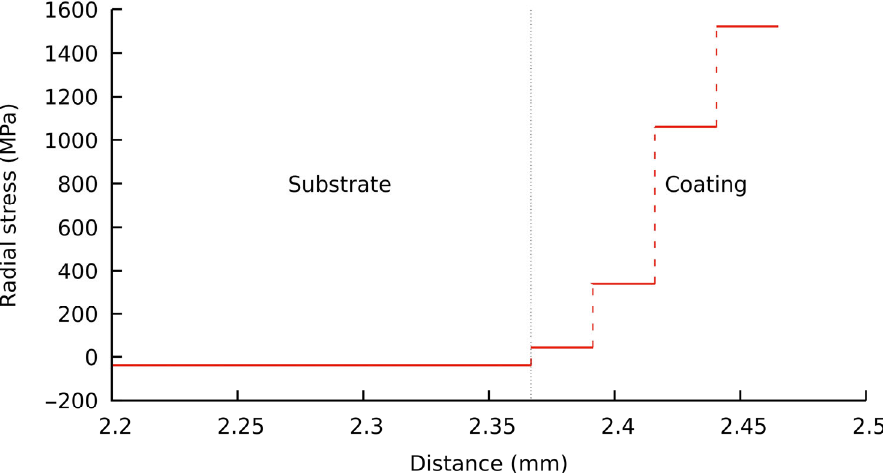
Figure 9. Through ‐ the ‐ thickness distribution of residual stresses in the central part of the disk. Figure 9. Through-the-thickness distribution of residual stresses in the central part of the Two ‐ dimensional distributions of the normal stress components are shown in Figure 10. One can see that the residual stresses differ in different layers. They are both negative (compressive) and positive (tensile). The stresses in the disk layers (sections) remain unchanged up to a region at the upper edge of the disk.